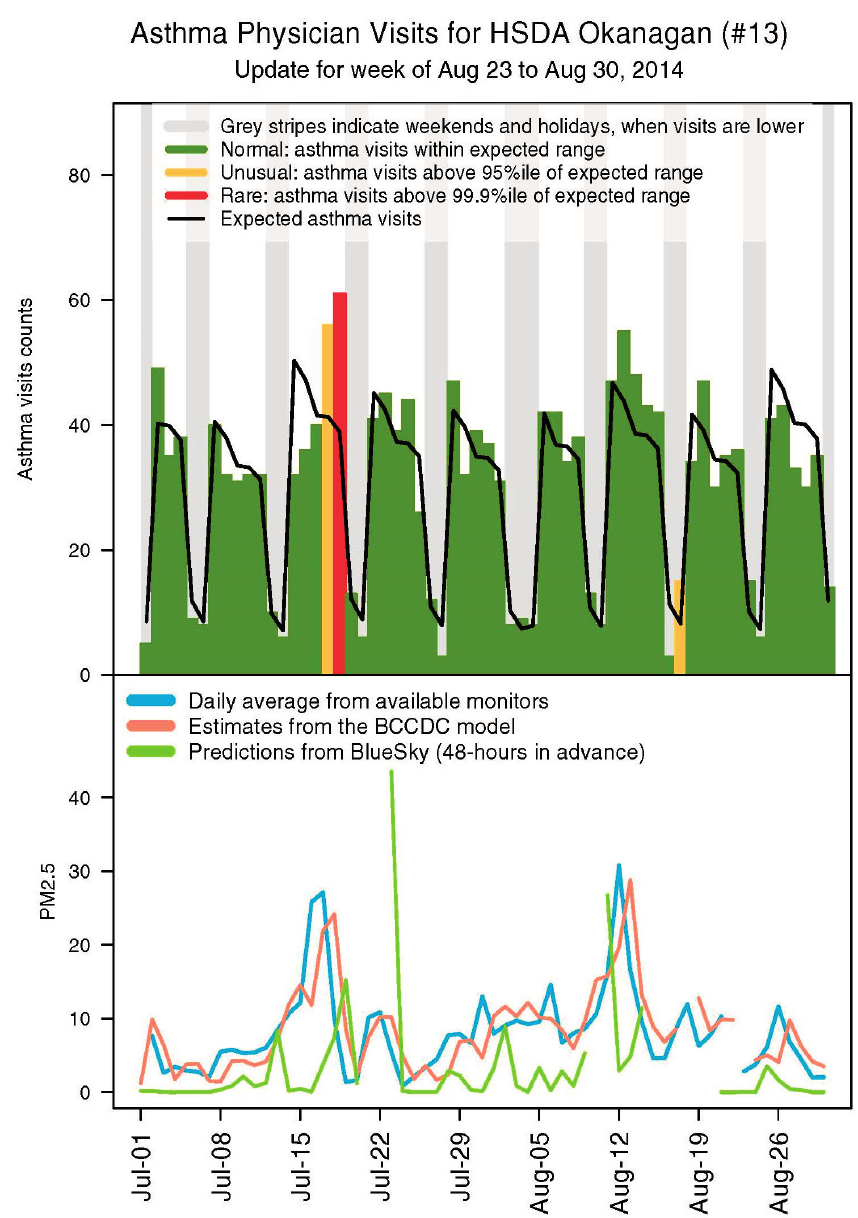
Figure 1. Sample Health Service Delivery Area (HSDA) summary page from a 2014 BC Asthma Monitoring System (BCAMS) report on outpatient physician visits. The upper panel shows expected daily counts of an asthma indicator, based on data from June 2012 onwards, and observed counts with any excursions highlighted. An alerting algorithm was used to identify excursions from the expected values, where counts over the 95th percentile of the expected distribution were considered unusual, and counts over the 99.9th percentile of the expected distribution were rare. The lower panel shows the different PM 2.5 metrics. The plot for BlueSky shows the prediction made 48 h previously for the current